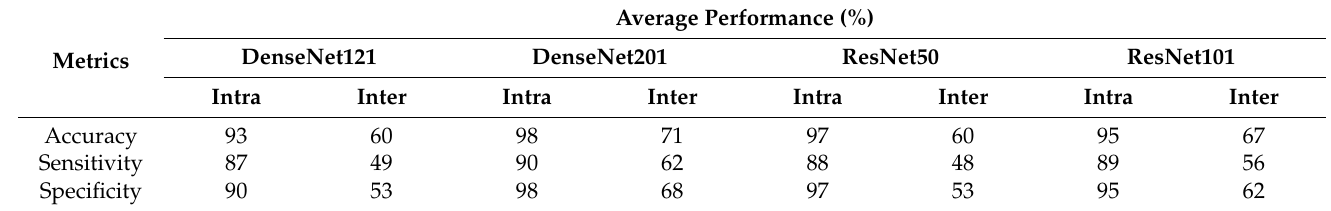
Table 5. Eight-class classification average performance with intra and inter-patient scenarios before data augmentation.